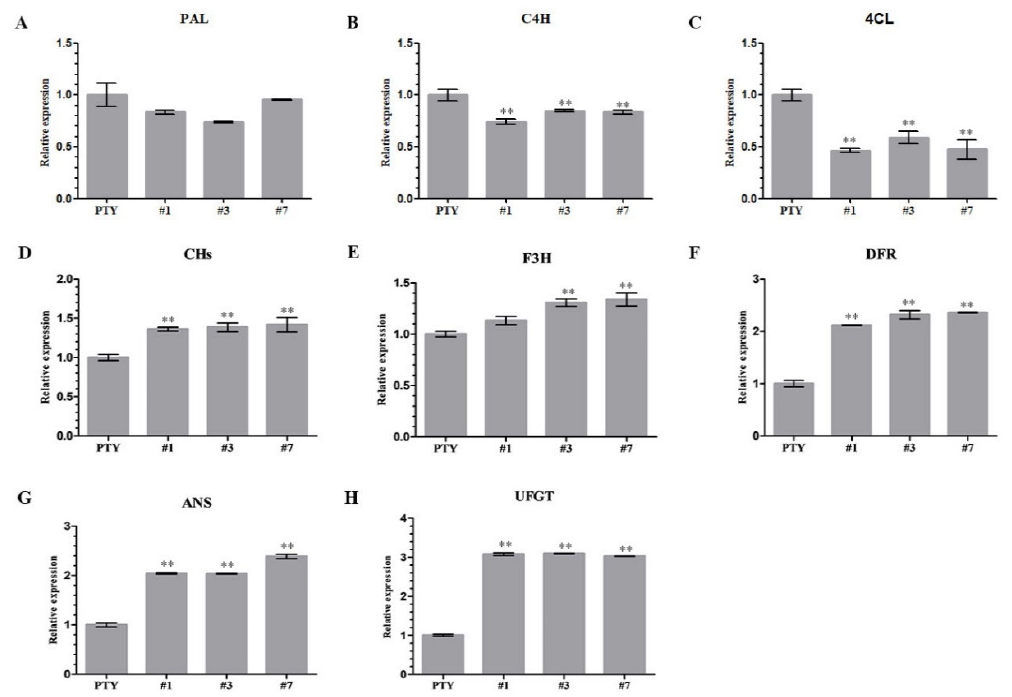
Figure 6. Effects of NoMYB60 silencing in watercress on transcription levels of genes related to flavonoid metabolism in watercress. ( A ) PAL: phenylalanine ammonia-lyase; ( B ) C4H: cinnamic acid 4-hydroxylase; ( C ) 4CL: 4-coumarate:CoA ligase; ( D ) CHs: Chalcone synthase; ( E ) F3H: flavanone 3-hydroxylase; ( F ) DFR: dihydroflavonol-4-reductase; ( G ) ANS: anthocyanin synthase; ( H ) UFGT: UDP-glucose:flavonoid 3- O-glucosyltransferase; ** represent p < 0.05.